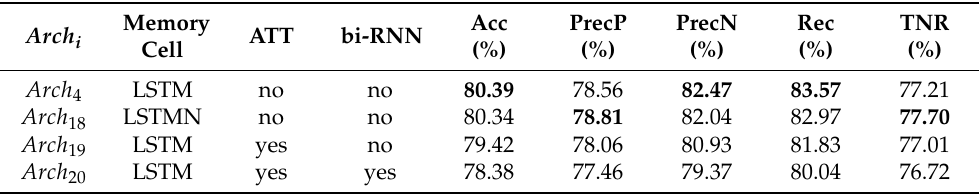
Table 8. Results of the attention mechanism experiment (test